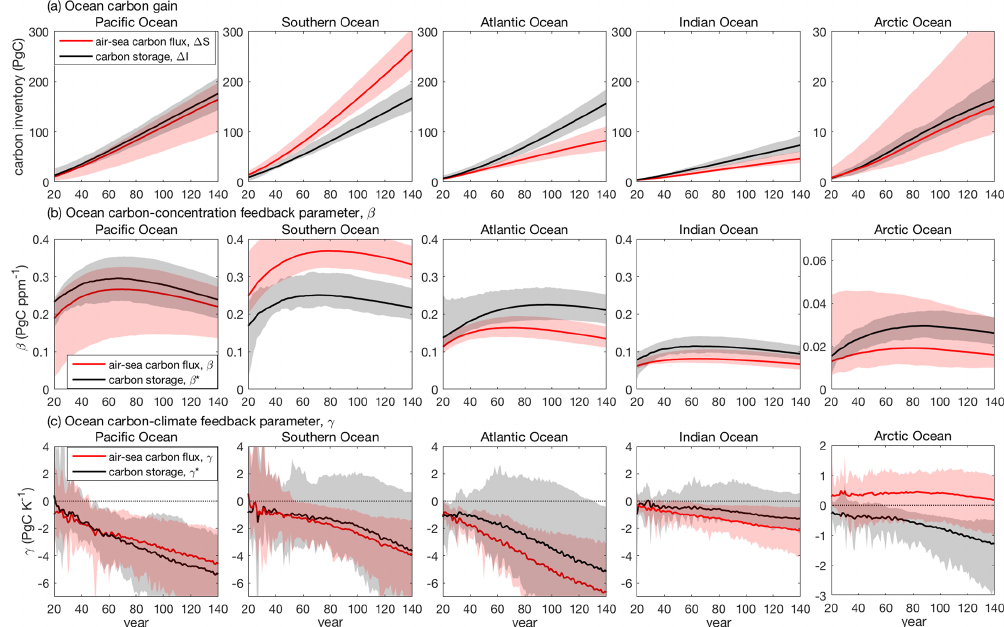
Figure A1. Ocean carbon storage and cumulative air–sea carbon flux in the Pacific, Southern, Atlantic, Indian and Arctic oceans in CMIP6 Earth system models, along with the ocean carbon cycle feedback parameters: (a) changes in the ocean carbon storage, (cid:49)I , and cu- mulative ocean carbon uptake, (cid:49) S , in petagrams of carbon, in the fully coupled simulations (COU) relative to the pre-industrial era; (b) carbon–concentration feedback parameter based on carbon storage, β ∗ (PgCppm − 1 ), and based on the cumulative carbon uptake, β (PgCppm − 1 ); and (c) carbon–climate feedback parameter based on carbon storage, γ ∗ (PgCK − 1 ), and based on the cumulative carbon up- take, γ (PgCK − 1 ). The solid lines and the shading show the model mean and the model range, respectively, based on the 1%yr − 1 increasing CO 2 experiment over 140 years in 11 CMIP6 models (Table 1). The estimates for the feedback parameters are based on the fully coupled simulation (COU) and the biogeochemically coupled simulation